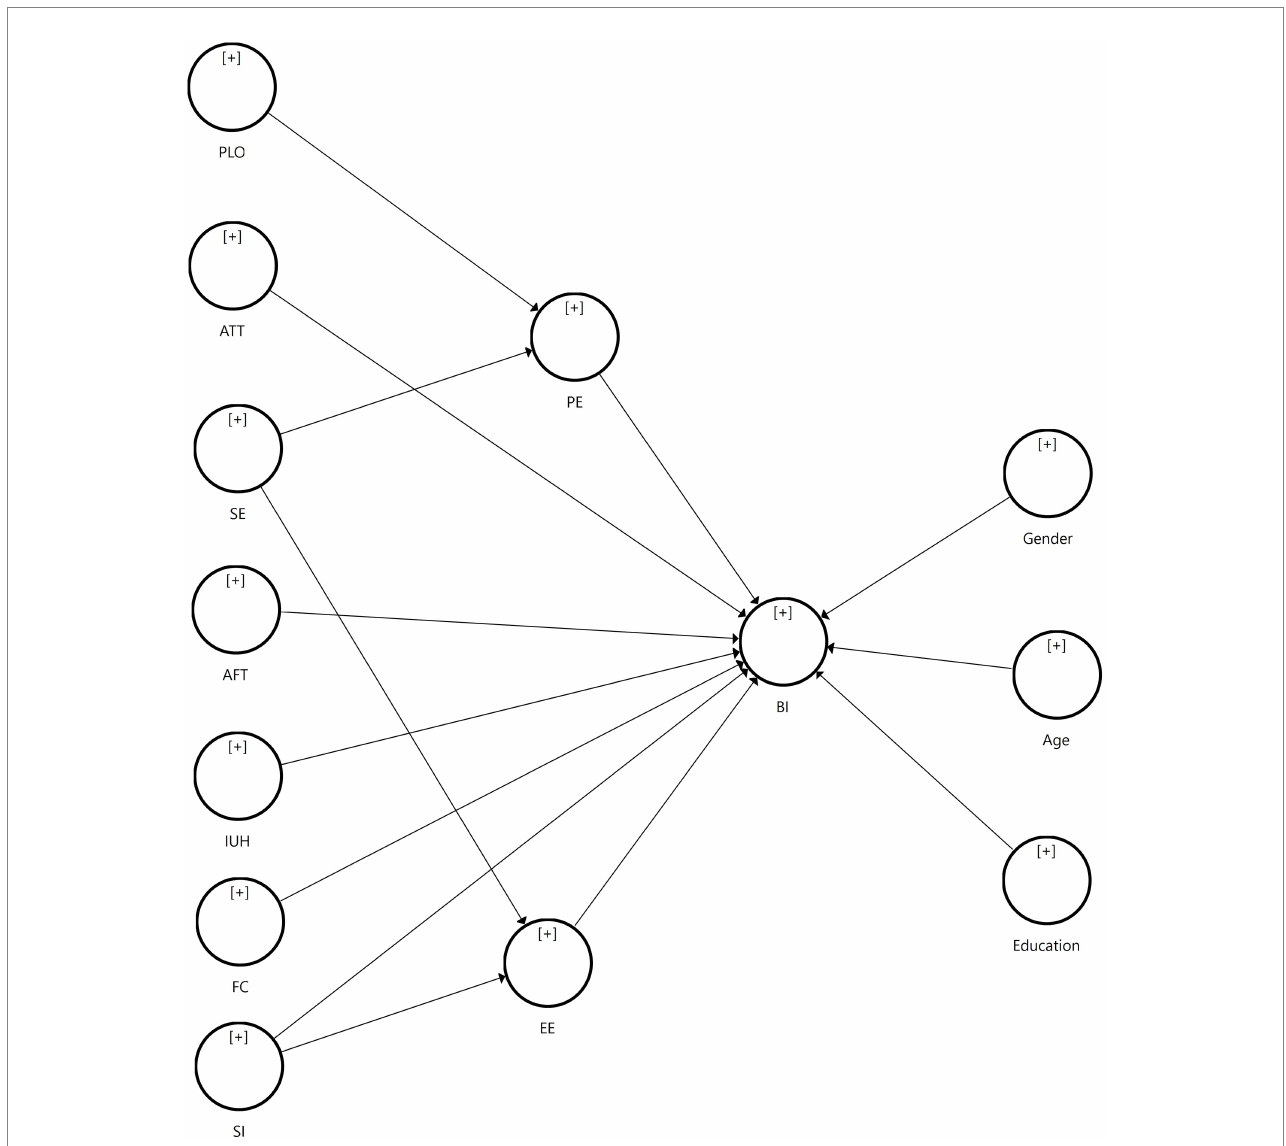
FIGURE 1 The proposed modified UTAUT